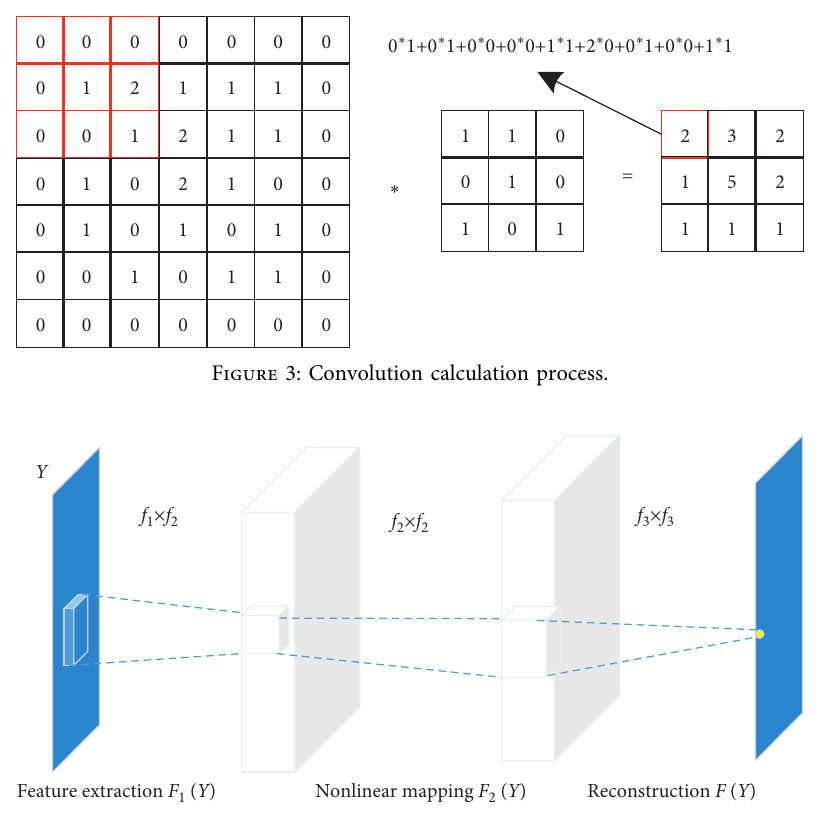
Figure 4: Structure diagram of nonlinear transformation neural network.